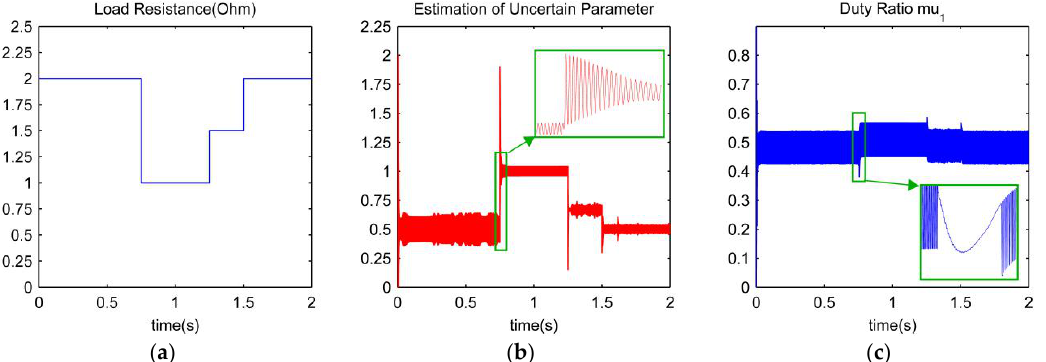
Figure 10. ( a ) Variation of DC load resistance; ( b ) Estimation of load conductance; ( c ) Duty cycle of switches created by proposed controller.